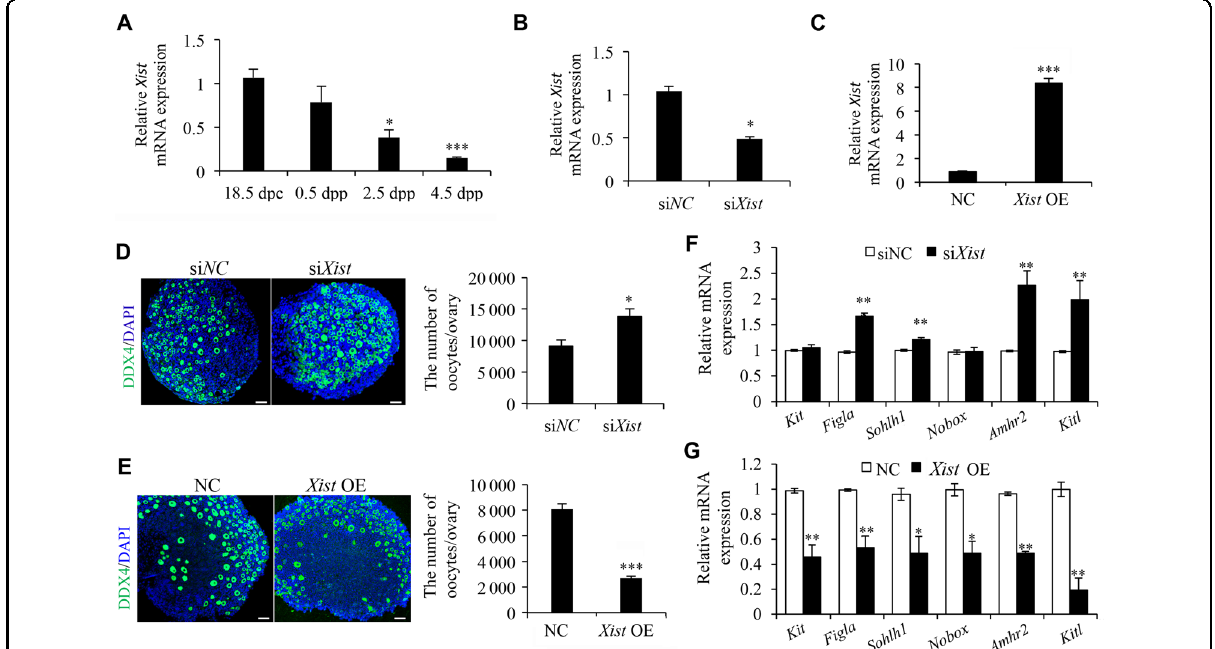
Fig. 1 Xist expression in perinatal ovaries is essential for PF pool formation. a qRT-PCR analysis of Xist expression at the indicated time points. Gapdh was used to normalize samples. b , c qRT-PCR analysis of Xist expression in newborn ovaries transfected with si Xist ( b ), and Xist OE ( c ), relative to respective controls. d , e Representative images of DDX4 immuno fl uorescence staining (left) and quanti fi cation of follicles (right) in newborn ovaries transfected with si Xist ( d ), and Xist OE ( e ). Scale bars: 50 μ m. f , g qRT-PCR analysis of genes involved in PF survival and development in si Xist ( f ), and Xist OE ( g ) transfected ovaries, relative to respective controls. Student ’ s t -test: * P < 0.05, ** P < 0.01, *** P <